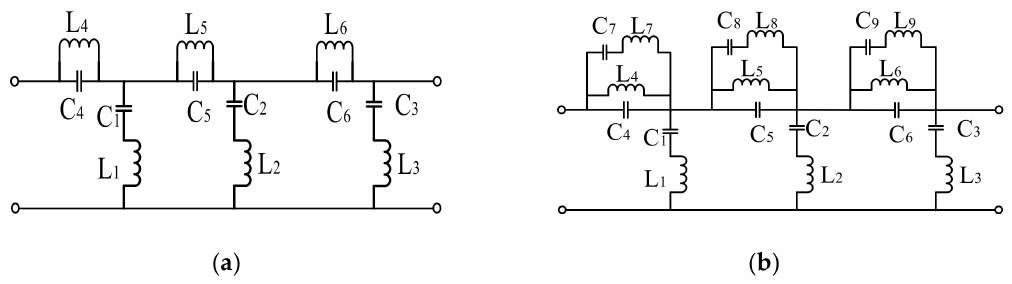
Figure 10. ( a ) Physical test photos of the band stop filter etched periodic hexagon ring EBGs; ( b ) physical measurement results of the band stop filter etched periodic hexagon ring EBGs.